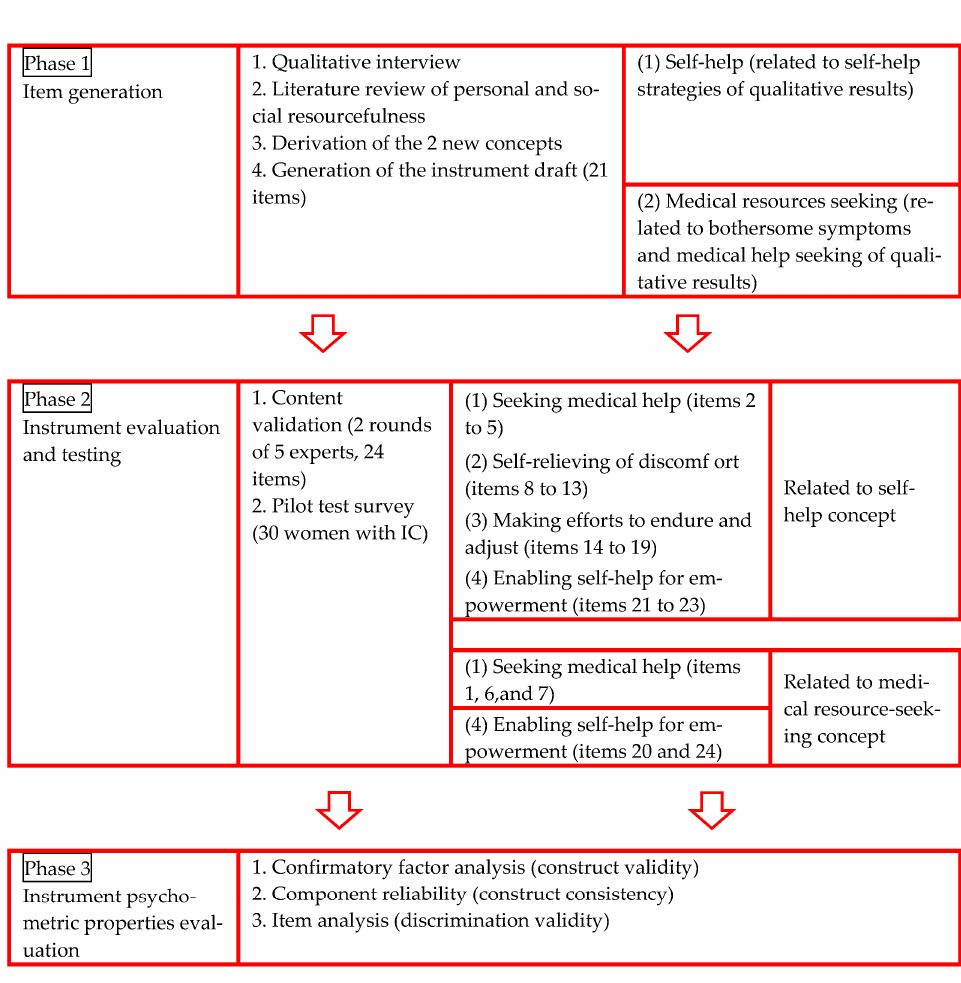
Table 1. Participant characteristics ( N = 100).